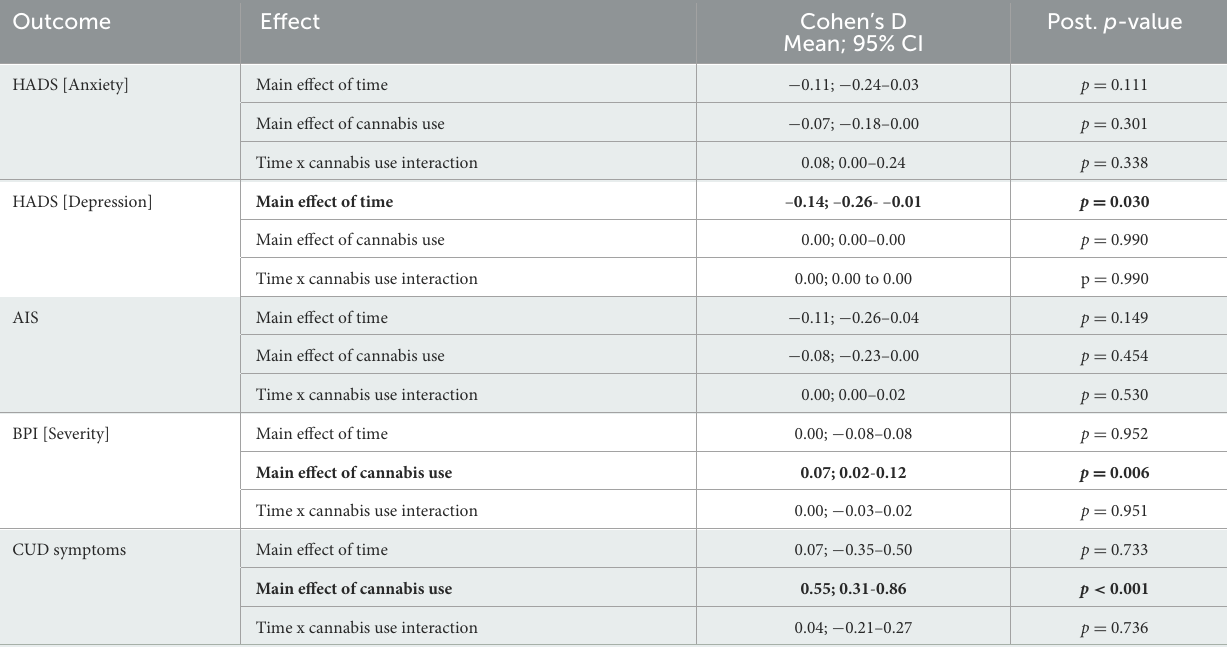
TABLE 3 Main effects of time and cannabis use frequency and their interaction for each clinical outcome.